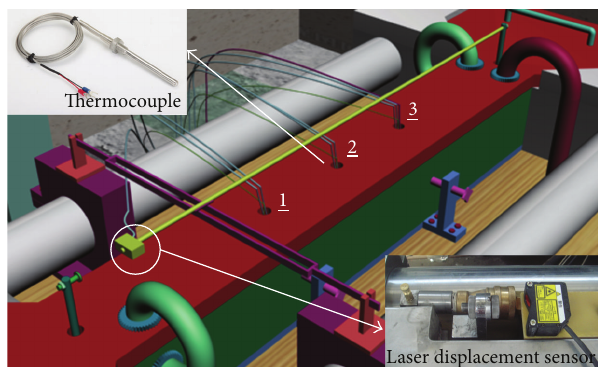
Figure 2: Laser displacement sensor and thermocouples.